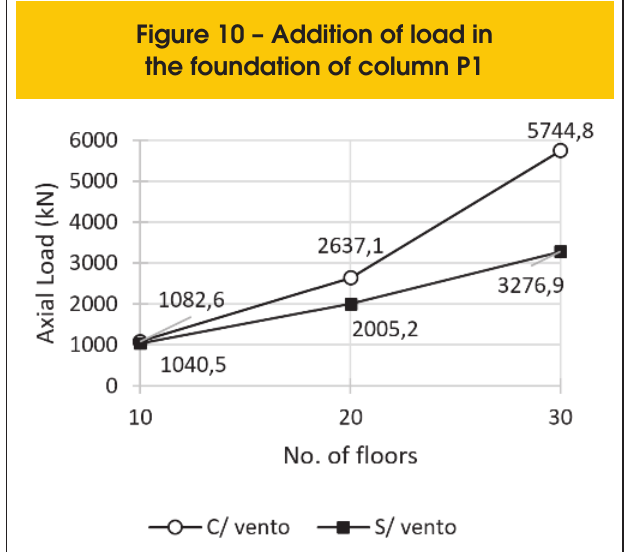
Figure 10 – Addition of load in the foundation of column